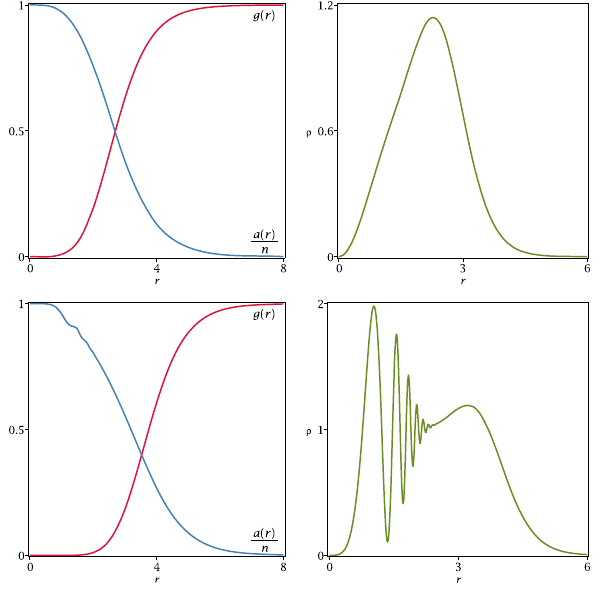
Fig. 10 Solutions of (18) with permeabilities given by (29). In the left, we show g 2 ( r ), g 3 ( r ) (red lines, from top to bottom) and a 2 ( r )/ n 2 , a 3 ( r )/ n 3 (blue lines, from top to bottom) for n 1 = 1, n 2 = 5 , n 3 = 10. In the right, ρ 2 ( r ) (top) and ρ 3 ( r ) (bottom) are